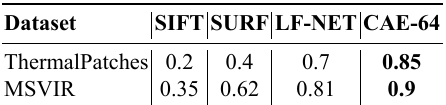
Table 1. PR AUC for MVSIR and ThermalPatches dataset.